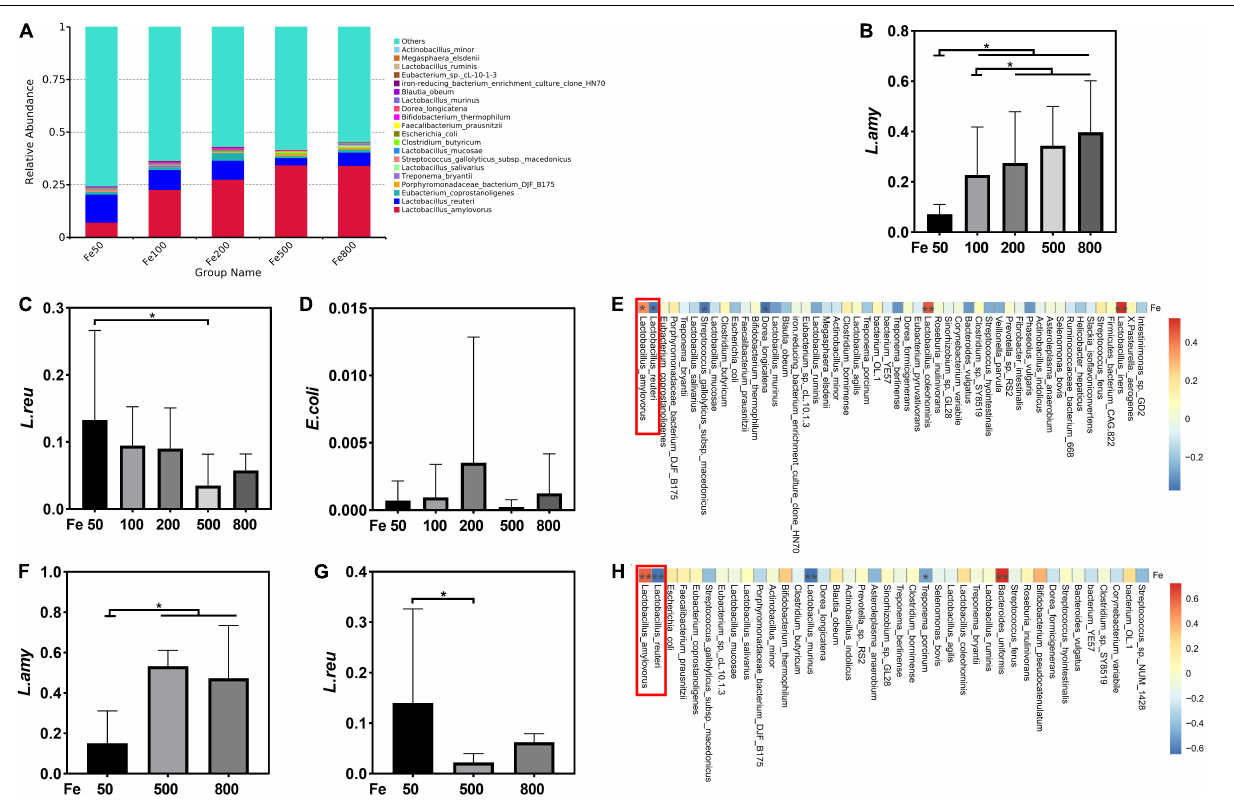
FIGURE 4 | Dietary iron shifted gut microbiology. The relative abundance of Lactobacillus amylovorus ( L.amy) and Lactobacillus reuteri ( L.reu) were dominant in the colon at the species level (A) . L.amy was significantly higher in the other groups than in the Fe50 group and was more enriched in the Fe200, Fe500, and Fe800 groups than that of the Fe100 group (B) . L.reu was significantly augmented in the Fe500 group than in the Fe50 group (C) , and Escherichia coli was not changed among the five groups (D) . Correlation analysis indicated that the abundance of L.amy , Lactobacillus coleohominis , and Lactobacillus iners were positively correlated with the iron concentration of colonic digesta, while the abundance of L.reu , Streptococcus gallolyticus , and Dorea longicatena were negatively correlated with the colonic digesta iron concentration (E) . Compared with that in the Fe50 group, L.amy was higher in the Fe500 and Fe800 groups (F) , and L.reu was lower in the Fe500 group (G) . Correlation analysis also demonstrated that cecal digesta iron positively and negatively correlated with L.amy and L.reu , separately (H) . Ordinary one-way ANOVA or Kruskal–Wallis test was used for the statistical analysis among different groups. Data were presented as mean ± SD. * P <